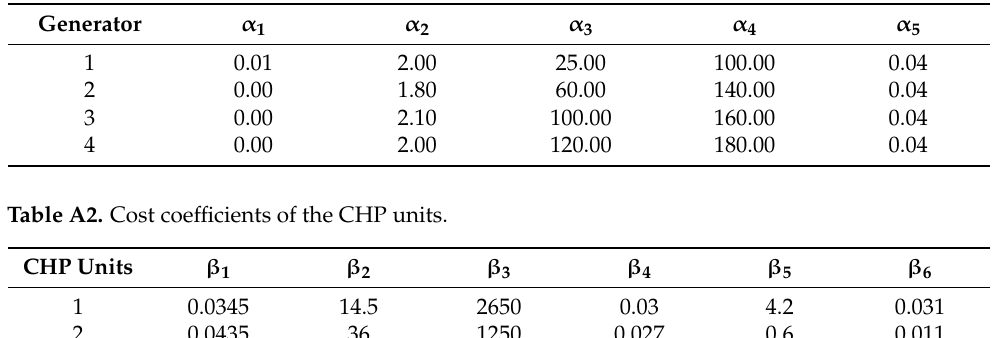
Table A1. Cost coefficients of the power-only units.